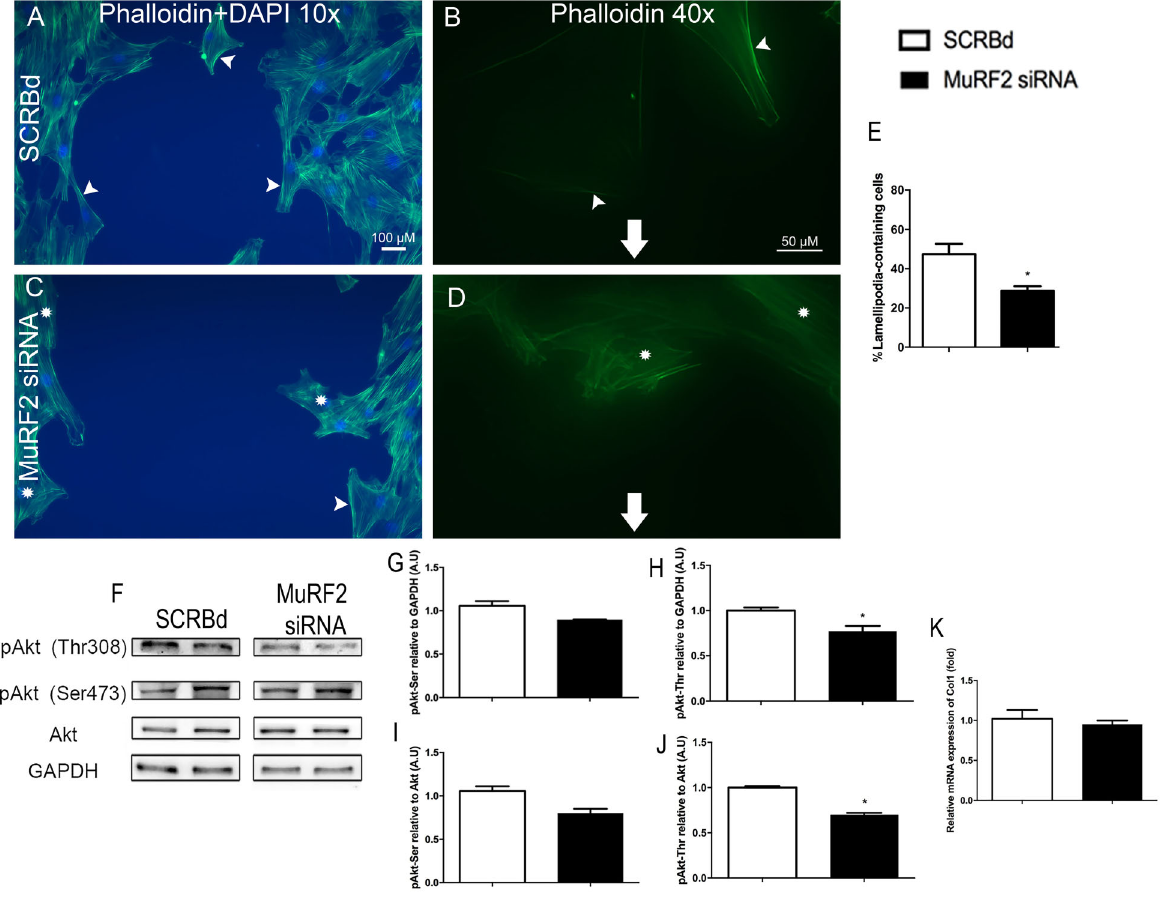
Figure 4. Knock-down of MuRF2 in skeletal muscle fi broblasts decreased lamellipodia formation. Staining for phalloidin and DAPI 24 h after the onset of wound healing assays at low ( A and C , 100 (cid:1) ; bar, 100 m M) and high ( B and D , 400 (cid:1) ; bar, 50 m M) magni fi cations; Skeletal muscle fi broblasts treated with scrambled (SCRBd) ( A and B ) and with MuRF2 siRNA ( C and D ). Arrowheads indicate actin stress fi bers, asterisks indicate misfolded actin cytoskeleton, and arrows indicate cell migration direction. E : Quanti fi cation of lamellipodia-containing cells. F : Representative immunoblots of pAkt Ser473, pAkt Thr308, total Akt, and GAPDH in skeletal muscle fi broblasts. The images belong to the same membrane. G – J : Densitometry from western blots. K : Real-time PCR for collagen 1 (Col1) in skeletal muscle fi broblast. Data are reported means ± SE. *P o 0.05 vs SCRBd ( t